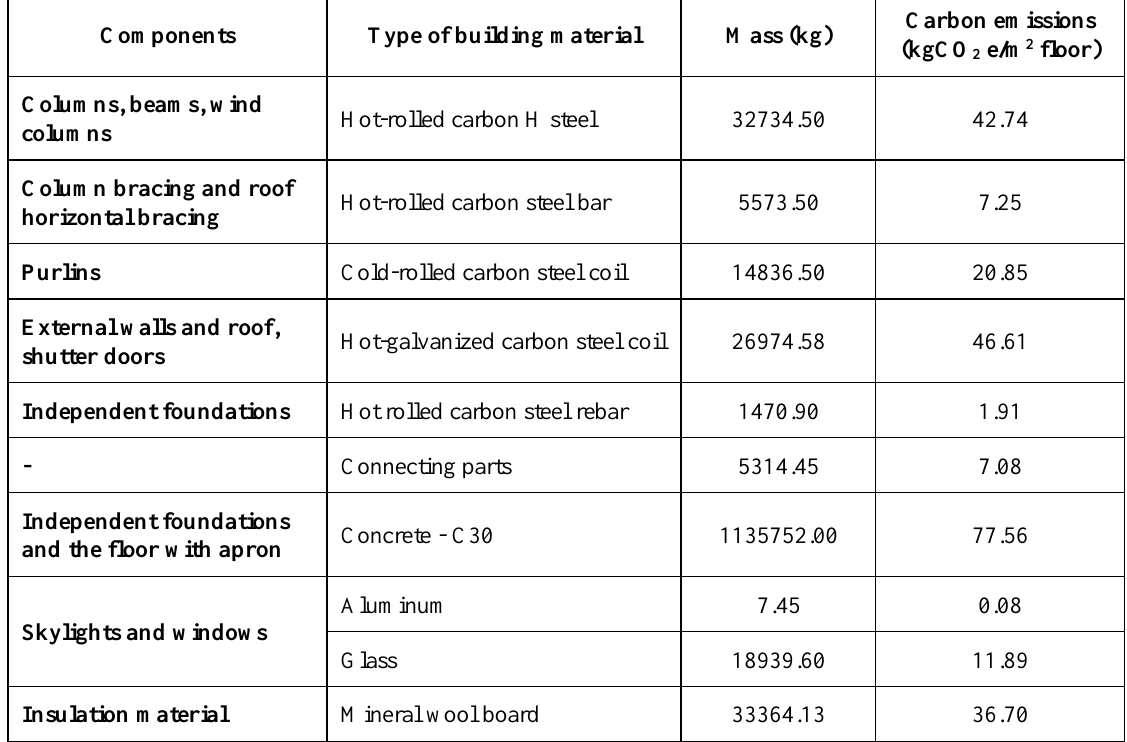
Table 4. The embodied carbon emissions of different materials used in the reference